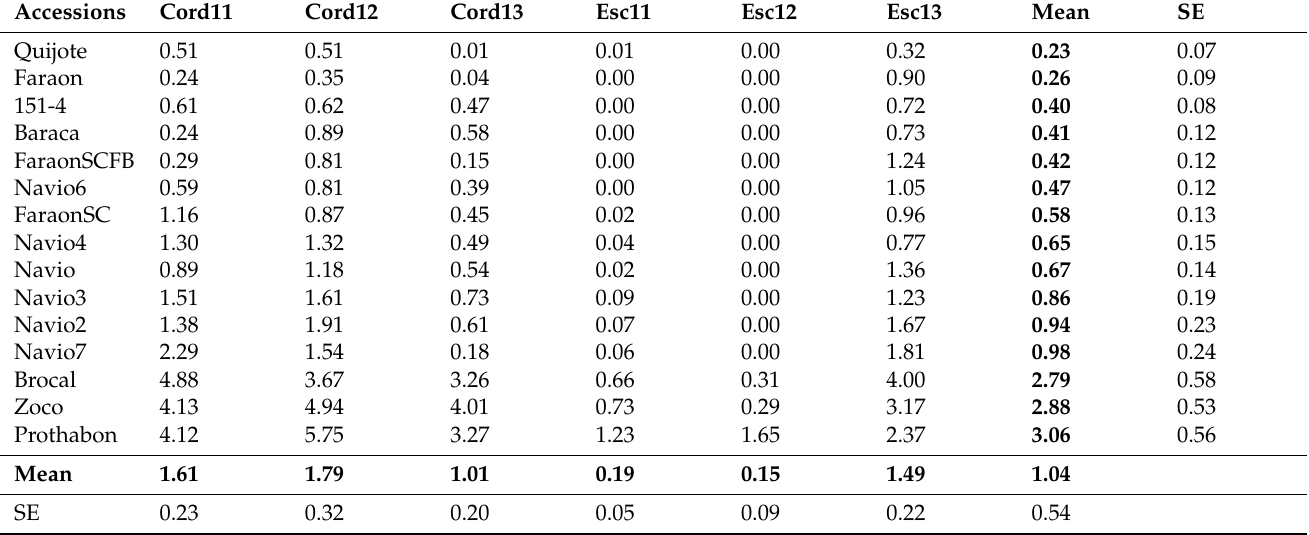
Table 5. Broomrape infection (Oc/plant) of 15 faba bean accessions grown at the studied